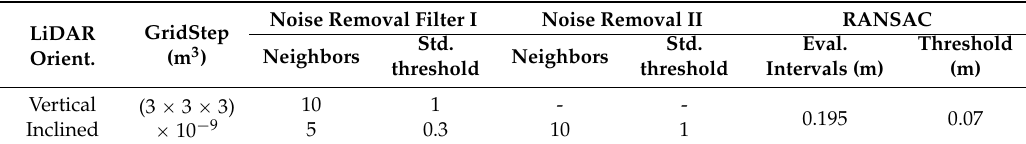
Table 3. Point clouds overlapping